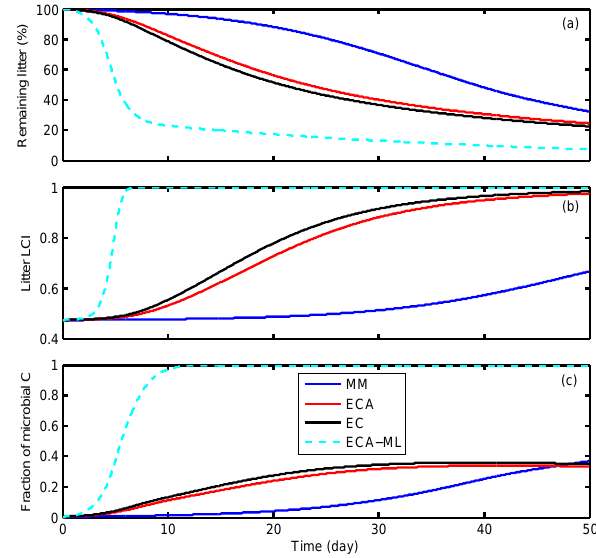
Fig. 7. Time series of state variable ratios simulated from the appli- cation of the four different substrates uptake kinetics to microbial model